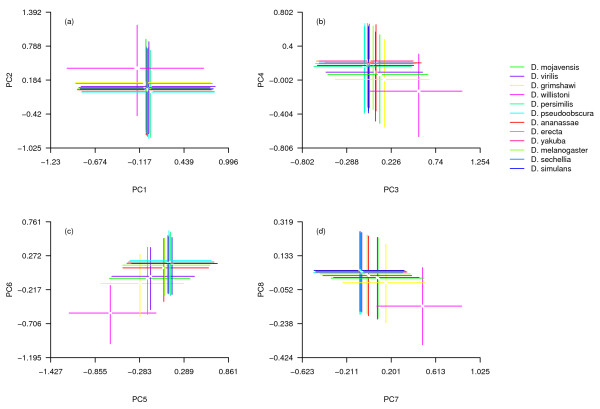
a-d composition of 12 Drosophila proteomes (lines, interquartile range; central gaps, 95% confidence intervals around the median). Axes are the same as in Figure 1.